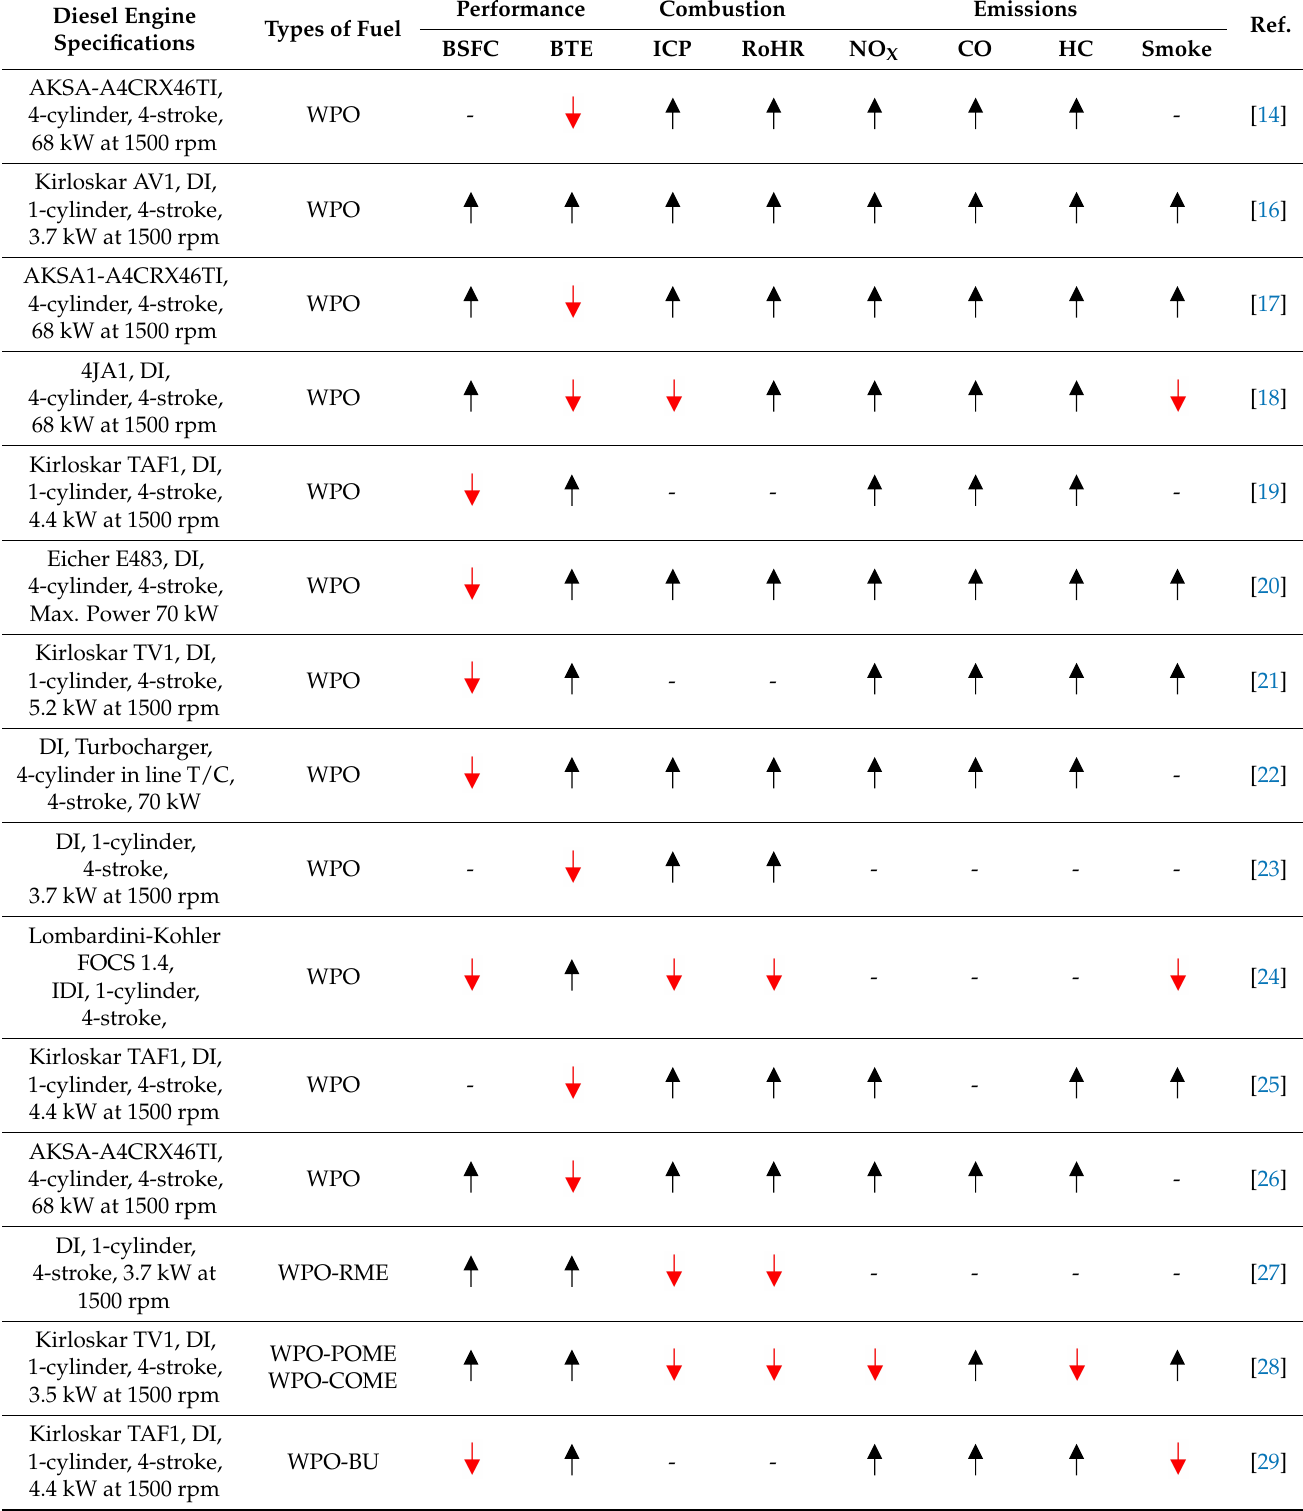
Table 1. Summary of previous investigations on using waste plastic oil (WPO) in diesel engines compared with diesel fuel operation.